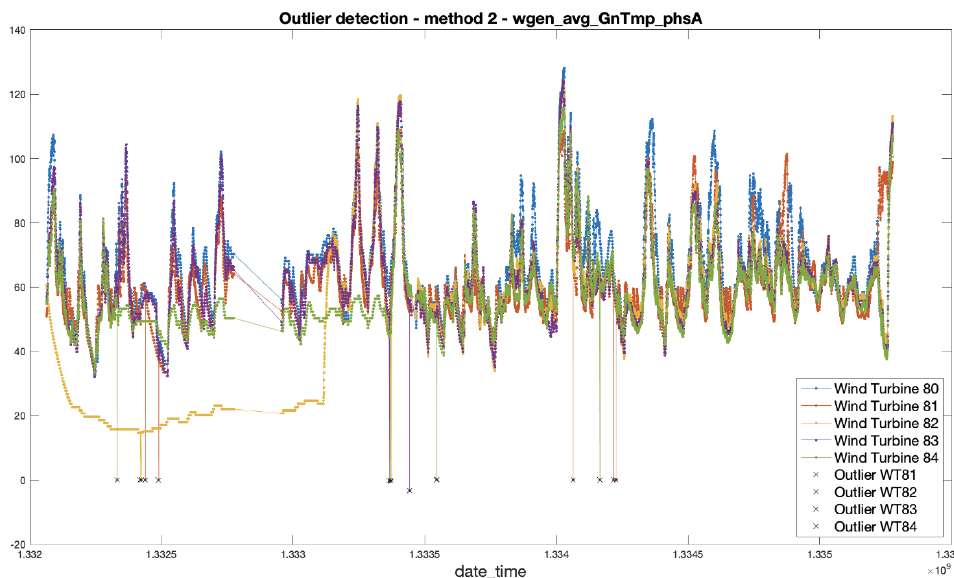
Figure 3. Graphical result of the proposed outlier filtering algorithm, consisting of determining that a value will be an outlier if it is more than 3.2 local standard deviations from the local mean calculated on a moving average window of 25 samples. Unlike the traditional method, this variant takes into account the local characteristics of the signal and does not remove the correct high amplitude values. The values of the outliers are indicated with a